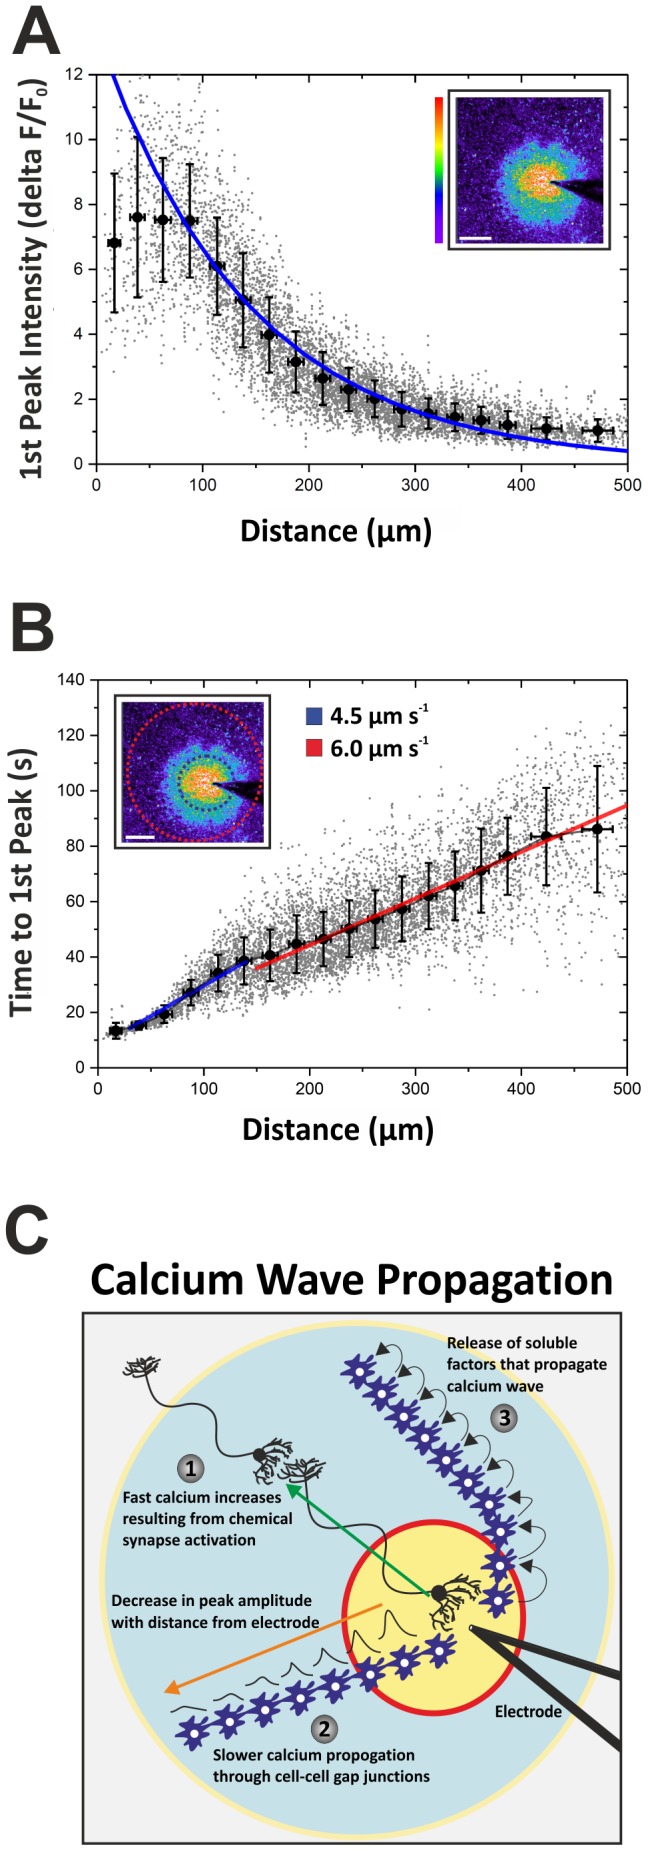
Calcium wave propagation in hippocampal slice cultures post-TBS.(A) Describes the relative increase in [Ca2+]i concentration (i.e. 1st Peak Intensity) in every cell (n = 6,536) post-TBS, with respect to distance from the electrode (0–500 µm). Within the first 100 µm from the point of stimulation, the Ca2+ fluorescence intensity of the first peak displays a wide range of values. From 100–500 µm, however, the fluorescence intensity of the first peak follows an exponential decay rate. Inset: Relative increase in [Ca2+]i fluorescence, depicted by a pseudo-colour rainbow palette, in hippocampal cells 15 s after TBS termination. (B) Graphed is the time it takes each cell to achieve its first peak in [Ca2+]i versus the distance that cell is from the electrode. Cells located further from the electrode take a longer time to reach their first peak in [Ca2+]i; the calcium wave travels at an average velocity of 5.2 ± 1 µm s−1. However, there appears to be a bi-phasic response in calcium wave propagation, illustrated by the blue and red linear fits of the data. The calcium wave travels slower 0–150 µm from the electrode, with an average speed of 4.5 µm s−1 (blue linear fit). Cells that lie 150–500 µm from the point of stimulation reach their first peak in [Ca2+]i relatively faster (red linear fit) as the velocity of the calcium wave increases, reaching 6.0 µm s−1. Inset: Illustrates how the velocity of calcium wave propagation increases >150 µm from the electrode. (C) Schematic diagram describing the mechanisms by which changes in [Ca2+]i may propagate over long distances in hippocampal slice cultures. The first method (1) is through action potential-mediated release of excitatory neurotransmitter (e.g. glutamate) at synapses located large distances from TBS-stimulated dendrites and cell bodies. This may explain the relatively small number of cells in panel B that are 300–500 µm from the electrode tip but exhibit very fast increases in [Ca2+]i and ‘time-to-first peak’ responses. Because the velocity of calcium wave propagation in hippocampal slice cultures appears to increase >150 µm from the point of stimulation, this may represent a transition from (2) gap junction-mediated [Ca2+]i propagation to (3) release of soluble factors (such as ATP) that stimulate neighbouring cells and perpetuate the calcium wave over long distances through astrocyte networks.